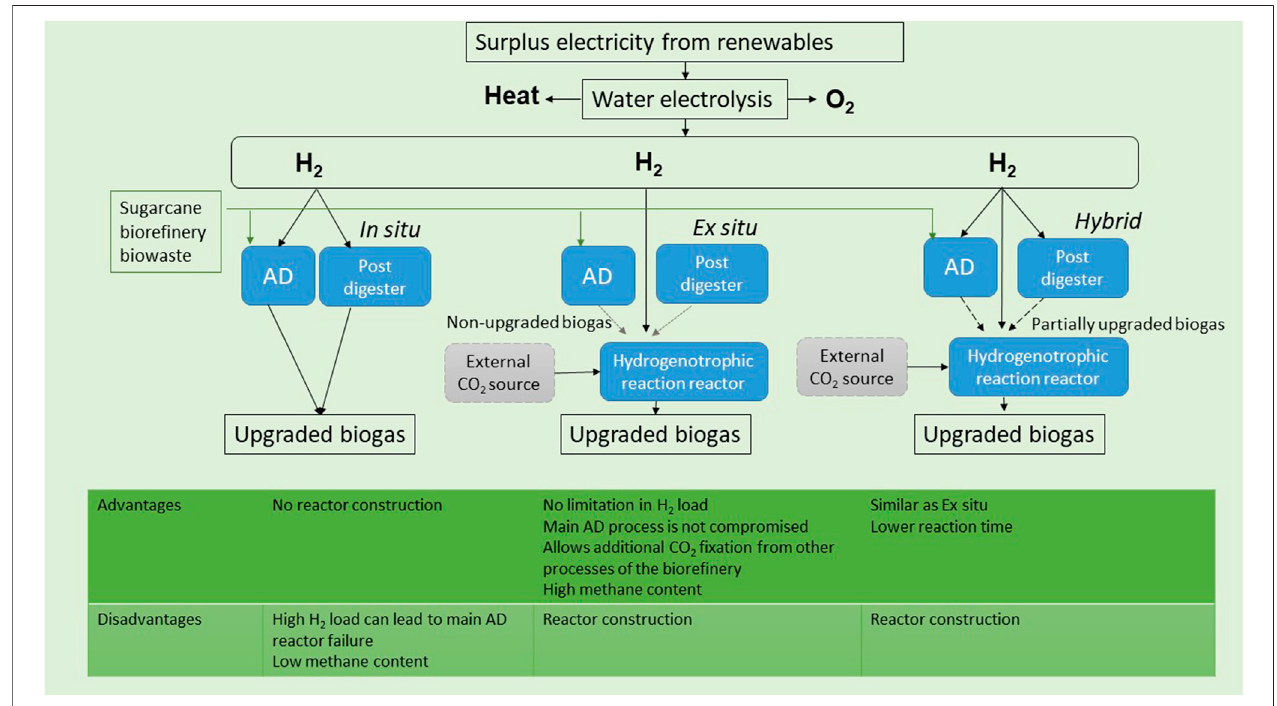
FIGURE 2 | P2G integration with the anaerobic digestion (AD) process of the sugarcane industry. Gray dotted arrow: Non-upgraded biogas and black dashed arrow: Partially upgraded biogas. Heat from the electrolyzer can be used for heating units and O 2 can be used for aerobic treatment or sold.